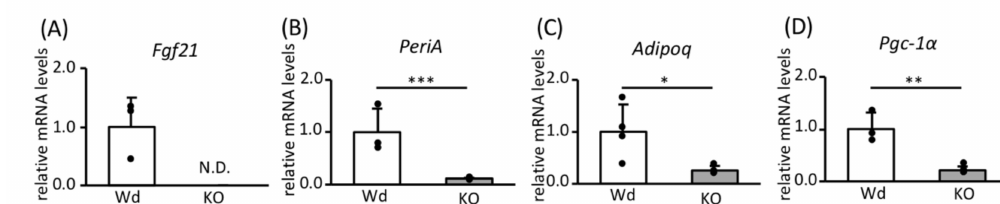
Figure 5. The e ff ects of FGF21 deficiency on the expression of adipocyte di ff erentiation markers and genes involved in mitochondrial biogenesis in mature adipocytes. MEFs were obtained from four individual embryos of either Wd or Fgf21 KO mice, di ff erentiated to mature adipocytes, and then RNA was extracted from each dish. The mRNA expression levels of Fgf21 ( A ), PeriA ( B ), Adipoq ( C ), and Pgc-1a ( D ) were analyzed using RT-PCR and normalized to Rps18 expression ( n = 4). Values are means ± SDs. * p < 0.05, ** p < 0.01 vs. Wd, according to Student’s t -test, *** p <